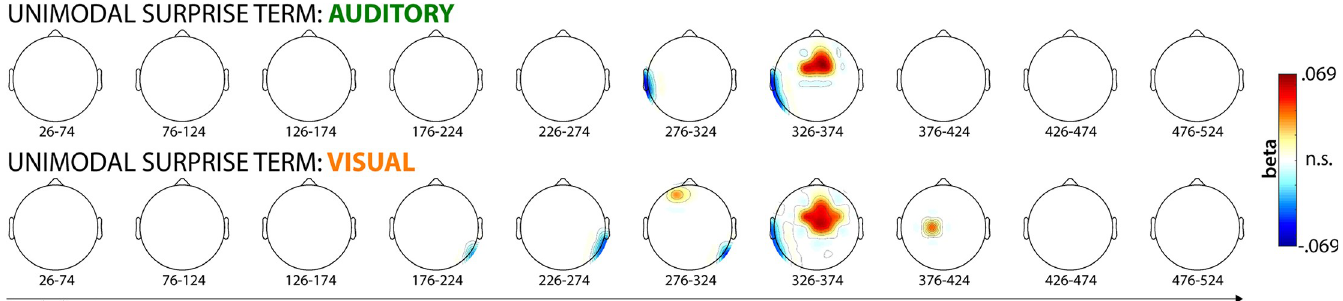
Fig 6. Split model fits of the within-domain surprise values, individually for each sensory domain. Scaling and significance threshold is the same as in Fig 4 (p < .00044). This plot shows that both the auditory and visual unexpected cues contribute to the significant single-trial fit of the separate surprise-terms model in Fig